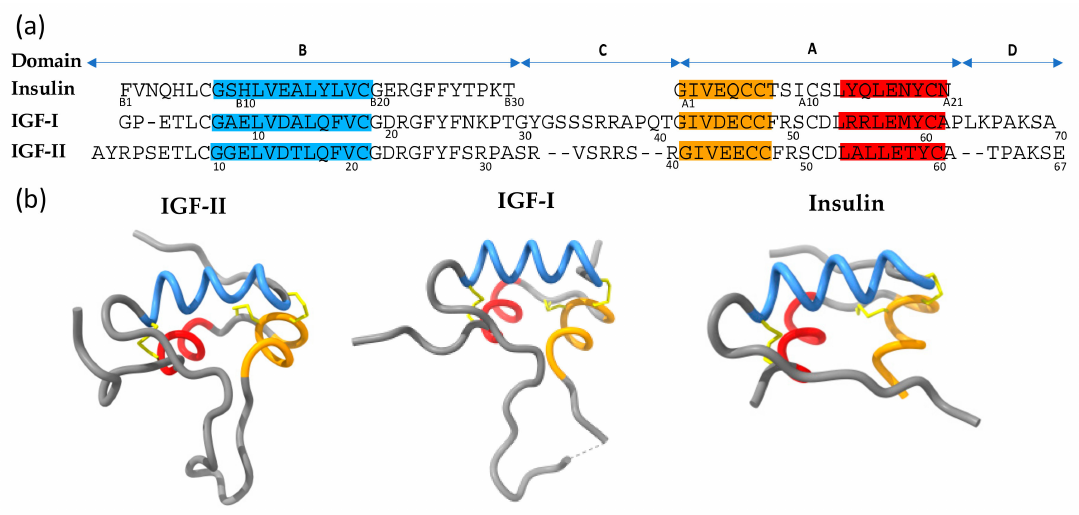
Figure 1. ( a ) Sequence alignment of IGF-II, IGF-I and insulin proteins. Domains are indicated above. Each peptide has three alpha helices; B-chain helix 1 (Blue), A-chain helix 2 (orange) and A-chain helix 3 (red). Residue numbers are indicated below each sequence. ( b ) Ribbon structures of the IGF and insulin proteins (PDB: 1IGL, 1GZR and 1MSO respectively). The three disulfide bonds in each protein are represented in